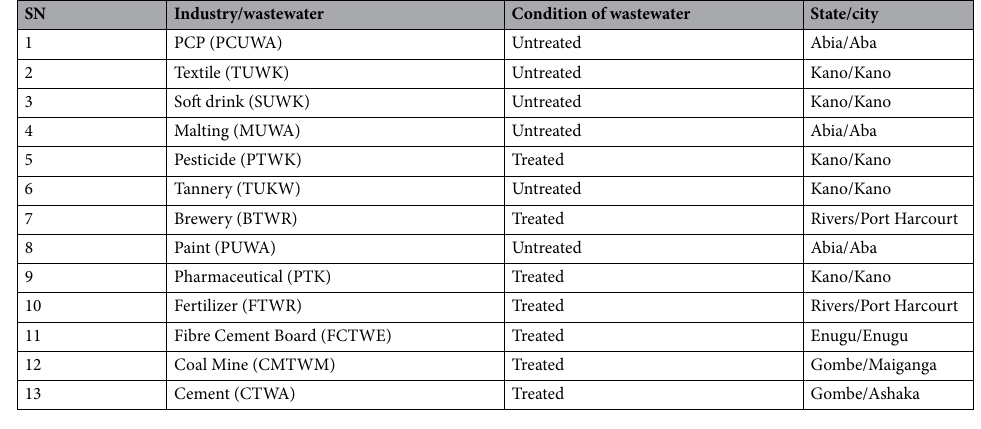
Table 1. Wastewater types and location of Industries. PCP Personal care product, effluent from PCP industry in Abia (PCUWA), effluent from textile industry in Kano (TUWK), effluent from soft drink industry in Kano (SUWK), effluent from malting industry in Abia (MUWA), effluent from pesticide industry in Kano(PTWK), effluent from tannery industry in Kano (TUKW), effluent from brewery industry in Port Harcourt (BTWR), effluent from paint industry in Abia (PUWA), effluent from pharmaceutical industry in kano (PTK), effluent from fertilizer industry in Port Harcourt (FTWR), effluent from fibre cement board industry in Enugu (FCTWE), effluent from coal mine industry in Gombe (CMTWM), effluent from cement industry in Gombe